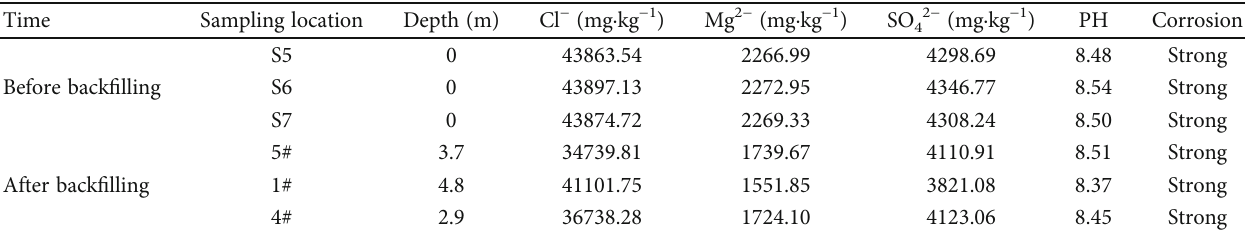
Table 2: Groundwater corrosion before and after back fi lling.